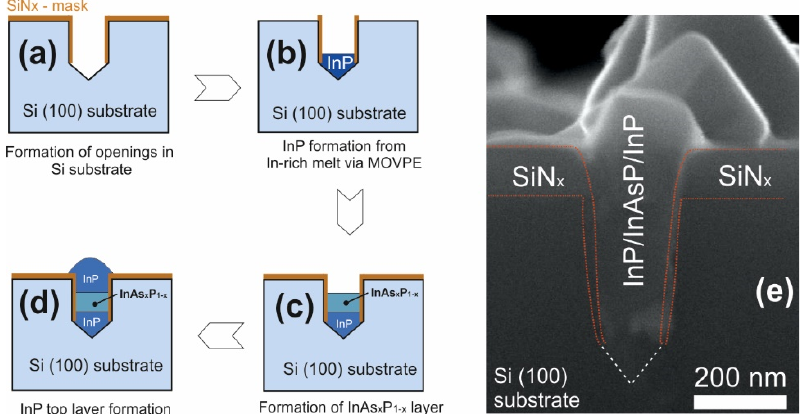
Figure 1. ( а – d )—scheme of the main stages of the formation of InP/InAs x P 1-x /InP nanoinclusions in Figure 1. ( a – d )—scheme of the main stages of the formation of InP/InAs x P 1 − x /InP nanoinclusions silicon using the MADSAG method,( e )—SEM image of a cross section of an InP/InAs x P 1-x /InP het- in silicon using the MADSAG method, ( e )—SEM image of a cross section of an InP/InAs x P 1 − x /InP erostructure in silicon. heterostructure in silicon.